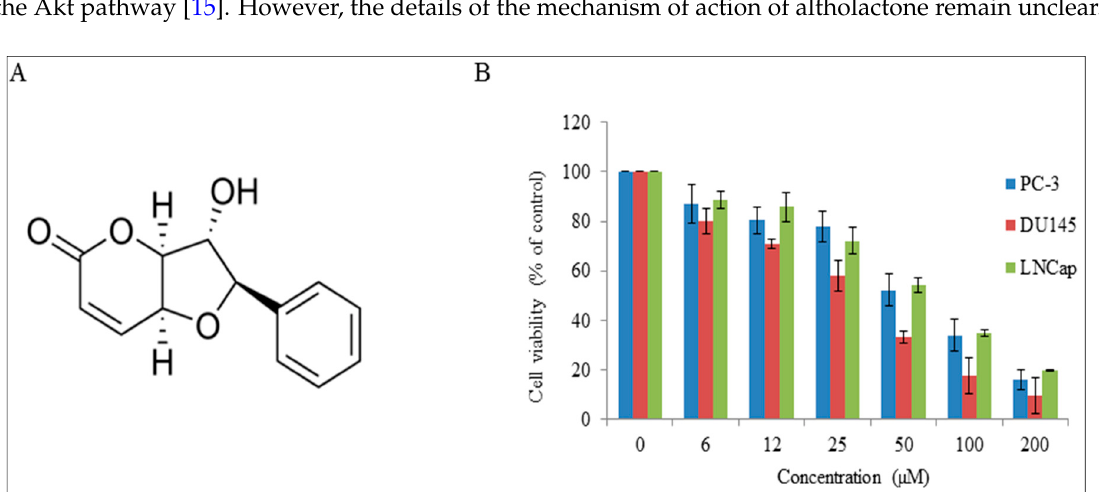
Figure 1. Chemical structure of altholactone and its effects on cell viability: ( A ) Chemical structure; ( B ) Altholactone inhibited the cell growth and induced cell death in prostate cancer cells. LNCaP, PC-3 and DU-145 cells were treated with the indicated doses of altholactone for 48 h and cell viability was measured by MTT assays. Data are expressed as mean ± SD ( n = 3).